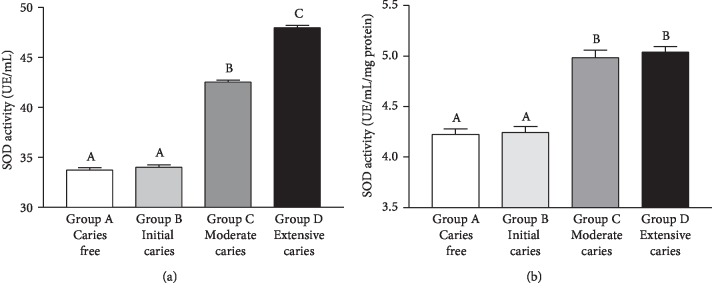
Superoxide dismutase (SOD) activity (in UE/mL for the graph in (a) and in UE/mL/mg protein for the graph in (b)) in saliva samples of caries-free children (Group A) and in those of with caries at different stages (Groups B-D). Bars represent the mean ± SD. Equal letters represent statistical similarity (p > 0.05) and different letters mean statistical differences (p < 0.001).